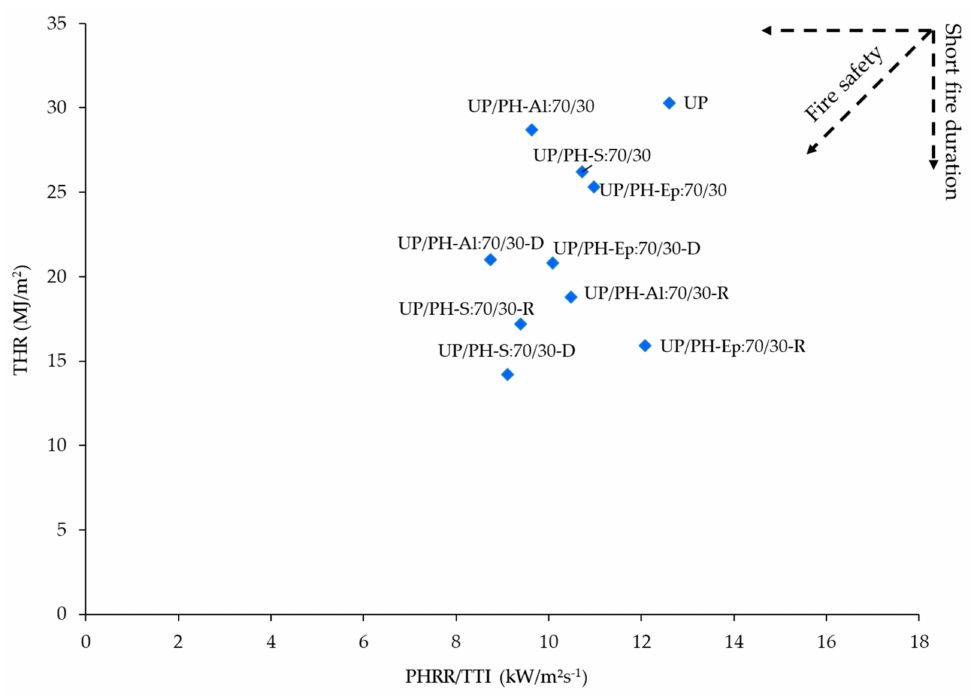
Figure 4. A fire safety assessment grid for GFRC of UP and its co-blended samples of UP/PH with and without FRs exposed to a 50 kW/m 2 heat flux.